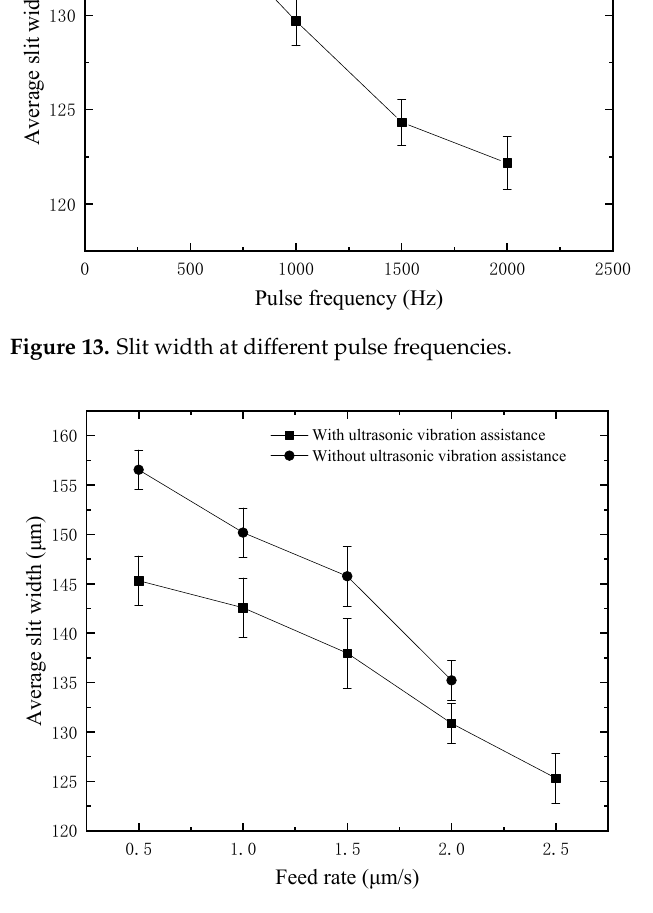
Figure 14. Slit width at different feed rates.